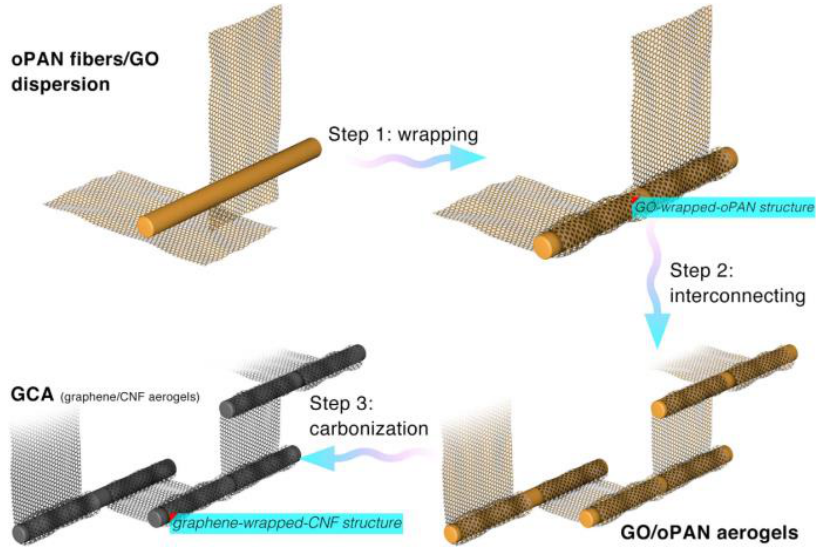
Figure 17. Formation process of GCAs through wrapping, interconnecting, and carbonization (reproduced from the work in [63] with permission).